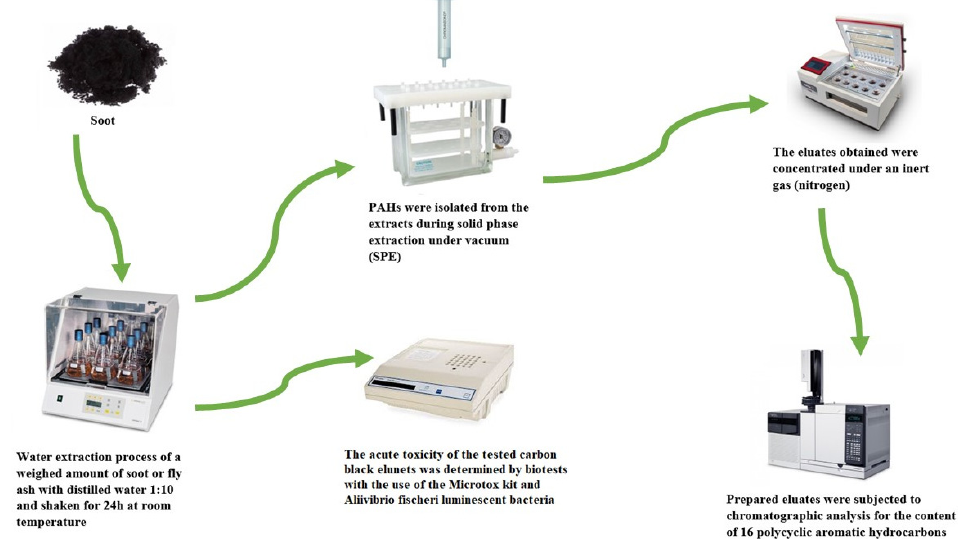
Figure 2. Isolation and analytical procedure for the determination of PAHs and Microtox test of eluents from soot samples.